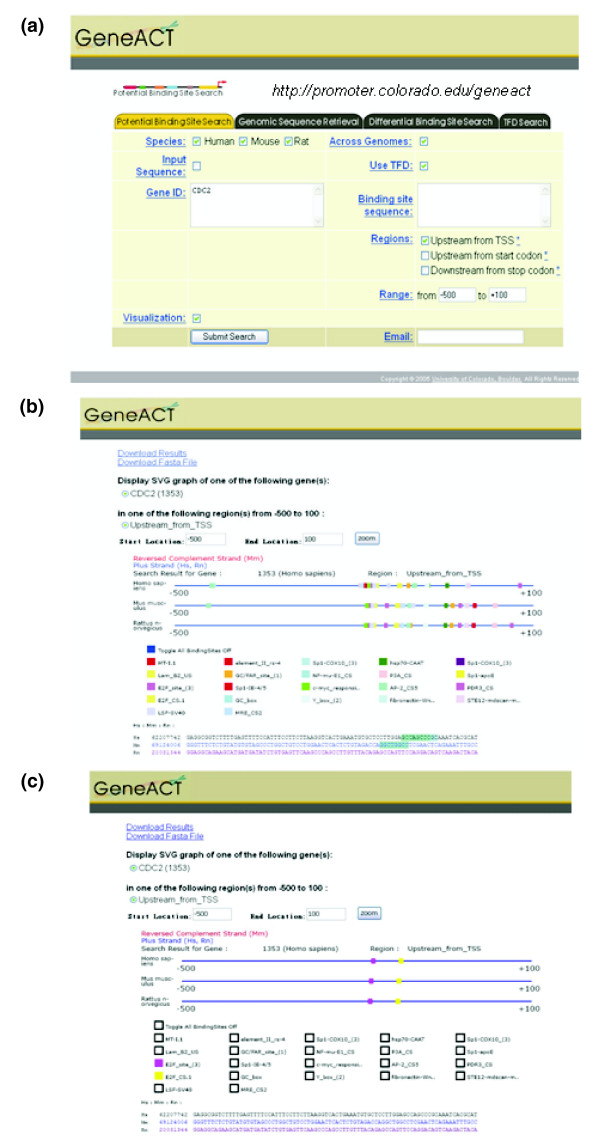
Web interface of the potential binding site search. (a) Web interface of potential binding site search. Gene IDs can be input in the form of either gene names (synonyms supported) or NCBI Entrez gene ID. There are currently three species to choose from (human, mouse, and rat) and it is optional to display whether the binding site sequence goes across genomes or to display all binding sites regardless of conservation across species. The user can specify a range of interest with three choices of regions (upstream from the transcription start site, upstream from the start codon, or downstream from the stop codon). Other than binding sites in the Transcription Factor Database (TFD), the user can input binding site sequences using standard IUB/IUPAC nucleic acid codes. For output option, the user can choose the visualization option for the promoter browser or a text file output. (b) Visualization of the CDC2 upstream region using GeneACT promoter browser. CDC2 upstream region (-500 to +100 base pairs) is shown, where +1 is the transcription start site. Only binding site sequences that go across all genomes are shown. Chromosomal locations of the binding site sequences and the full sequences are available in text file format via the 'download result' and 'download FASTA file' links. (c) Visualization of elongation factor-2 (E2F)-binding sites in the CDC2 upstream region. It is the same region as is shown in Figure 3b, with only the E2F sites highlighted. Other binding sites were suppressed by the toggle.